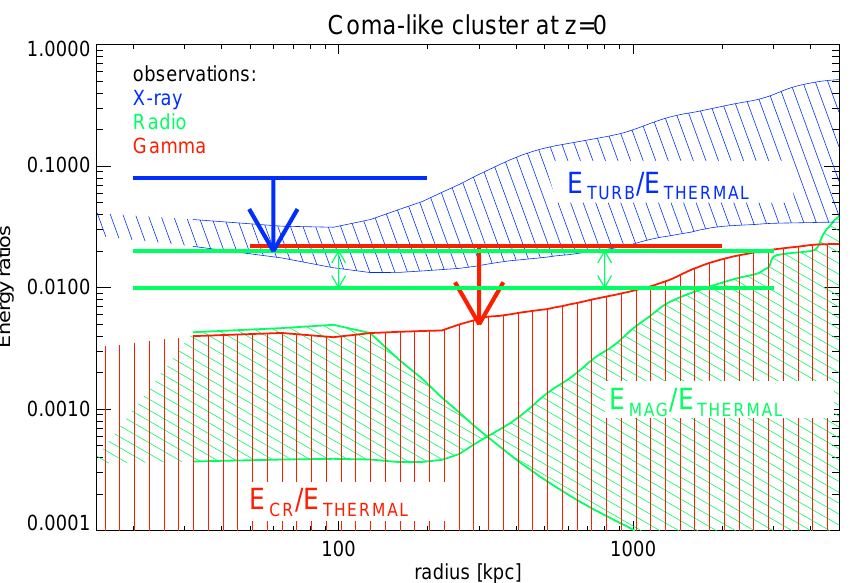
Figure 2. Radial profile of the ratios between NT energies and the thermal energy of the ICM for a simulated galaxy clusters at z =